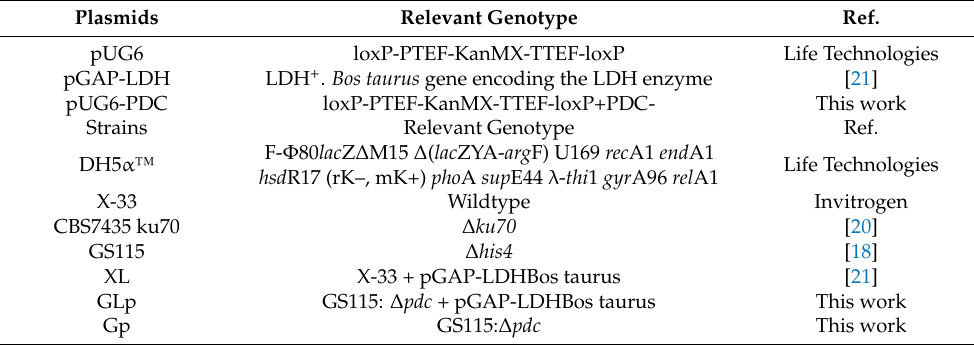
Table 1. Plasmids and strains used and developed in this work.